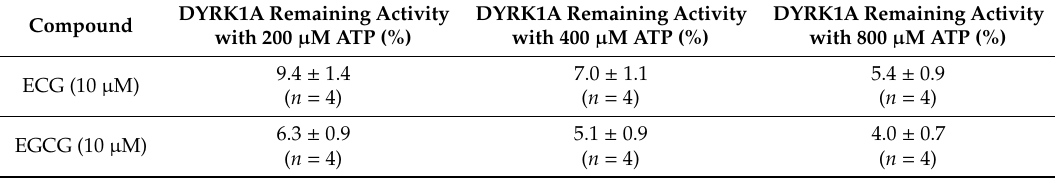
Table 4. Analysis of the inhibition of DYRK1A activity by ECG and EGCG as a function of ATP concentrations.